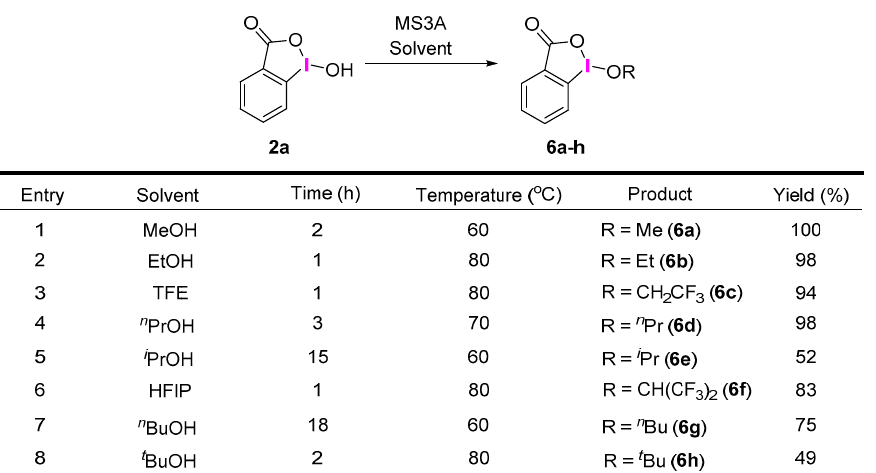
ing IBAs 2a – i (Scheme 4). IB-OAc 7a was easily produced in good yield by ligand